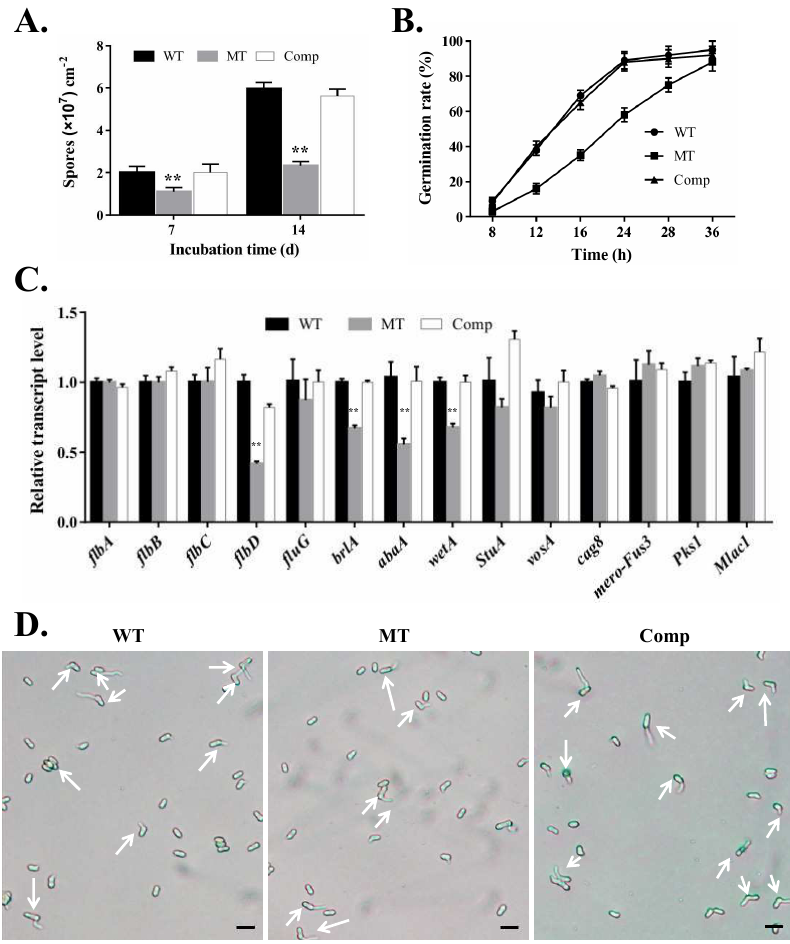
Figure 3. MrUBI4 is required for conidiation and conidial germination. (A) Conidial yields of di ff erent strains cultured on PDA plates for 7 and 14 days. (B) Kinetics of conidial germination. Conidial germination rate 8-36 h after inoculation is presented. (C) Relative expression analysis of conidiation-related genes in the 2.5-day-old PDA cultures. (D) Representative images of conidial germination 12 h after inoculation. Arrowhead (white) depicts germinated conidia. Scale: 10 µ m. **, p < 0.01. WT: wild-type strain, MT: ∆ MrUBI4 strain, Comp: complementary